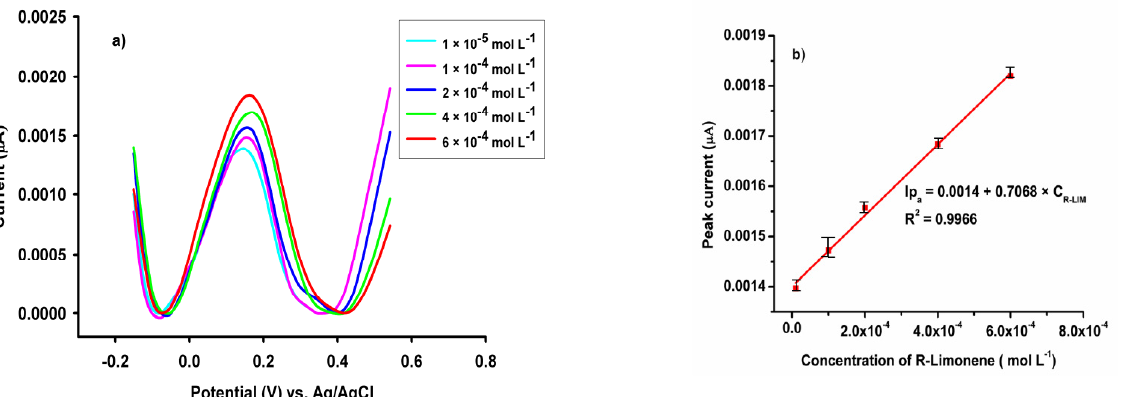
Figure 6. ( a ) Differential pulse voltammograms recorded with the TPP/AuNPs-S-Gr sensor in PBS pH 2.0 containing different concentrations of R-limonene from 1 × 10 − 5 mol L − 1 to 6 × 10 − 4 mol L − 1 . ( b ) Calibration curves obtained with the TPP/AuNPs-S-Gr sensor from 1 × 10 − 5 mol L − 1 to 6 × 10 − 4 mol L − 1 . Working conditions: step potential of 0.025 V; scan rate of 0.025 V s − 1 .